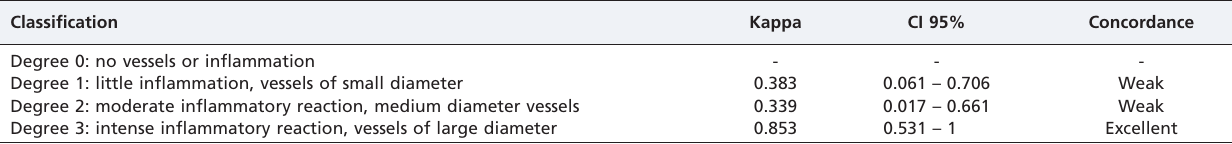
Table 4 - Concordance analysis among the evaluations with respected to vessel diameter/inflammation.